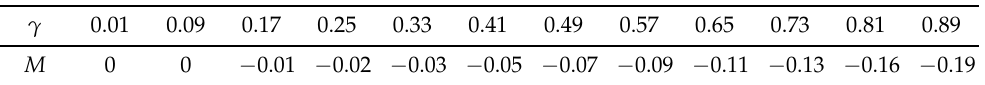
Table 8. Values of the medial correlation of the SGCC copula for θ = ( − γ ,1/ values of γ , belonging to Configuration